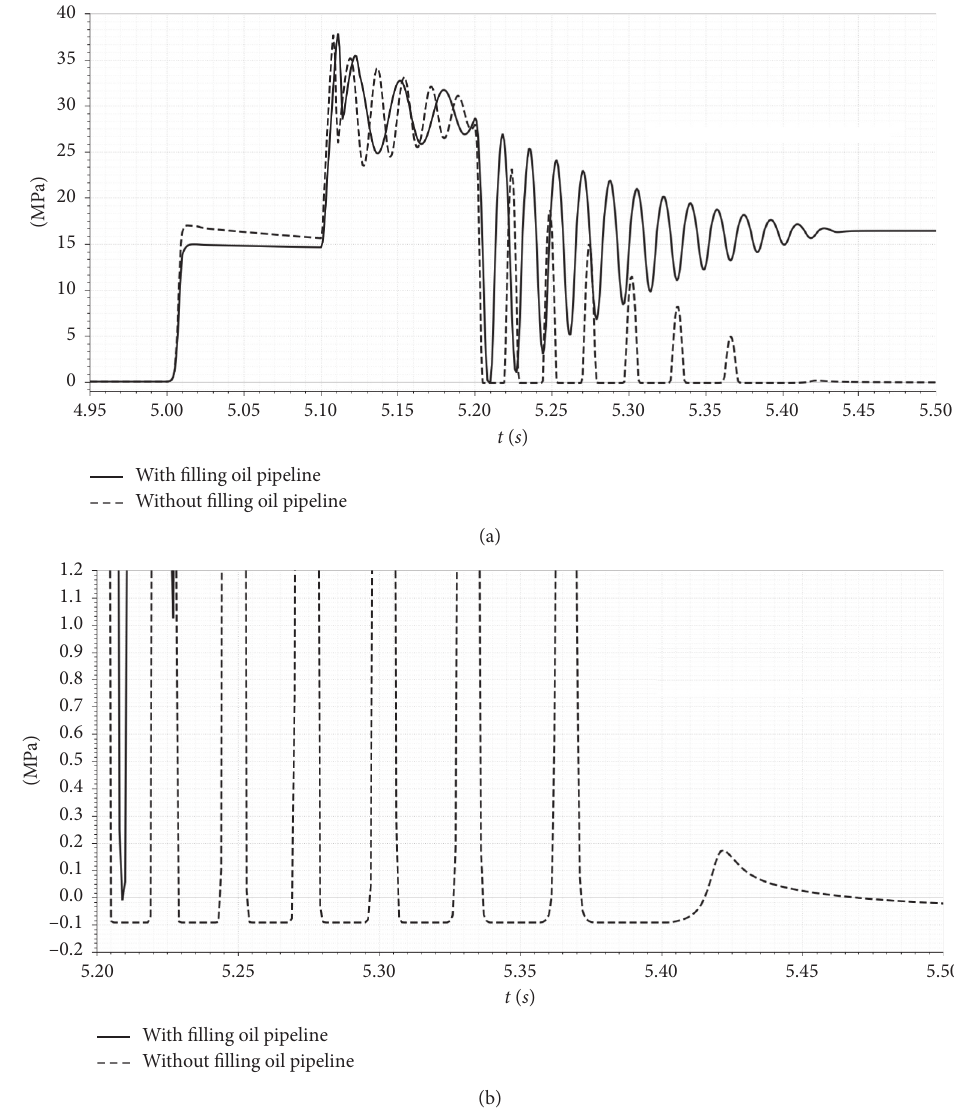
Figure 9: Comparison curve of the hydraulic motor of power head with or without filing oil pipeline: (a) original curve; (b) magnification